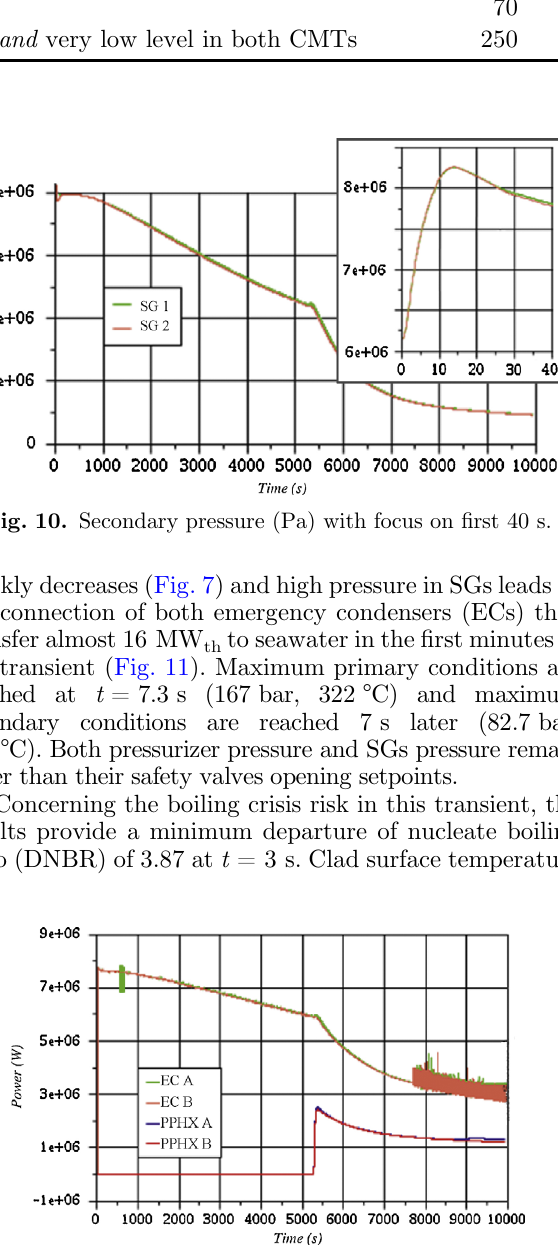
Fig. 9. Primary pressure (Pa) during fi rst 100 s.